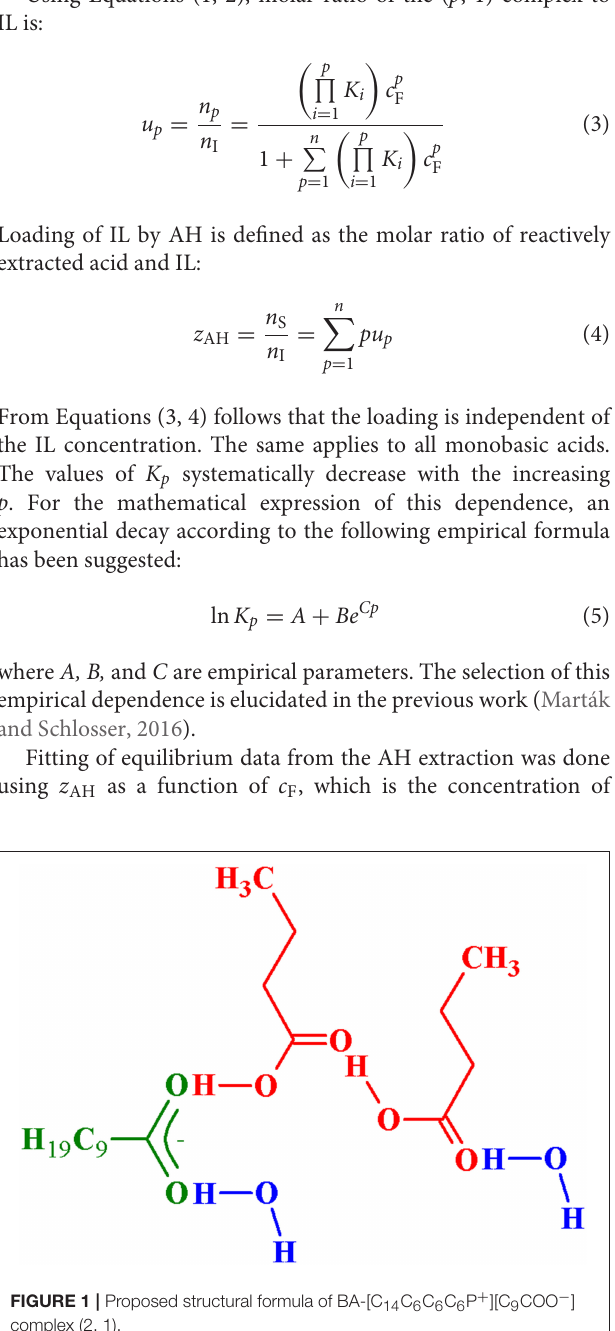
Figure 1 . The proposed structural formulas of ( p , 1) complexes were published in our previous works (Marták and Schlosser, 2016, 2017). For more hydrophobic acids, e. g. butyric acid (BA), the acid-IL and acid-acid hydrophobic interactions between hydrocarbon chains occur. In such case K p is lumped constant including also van der Waals